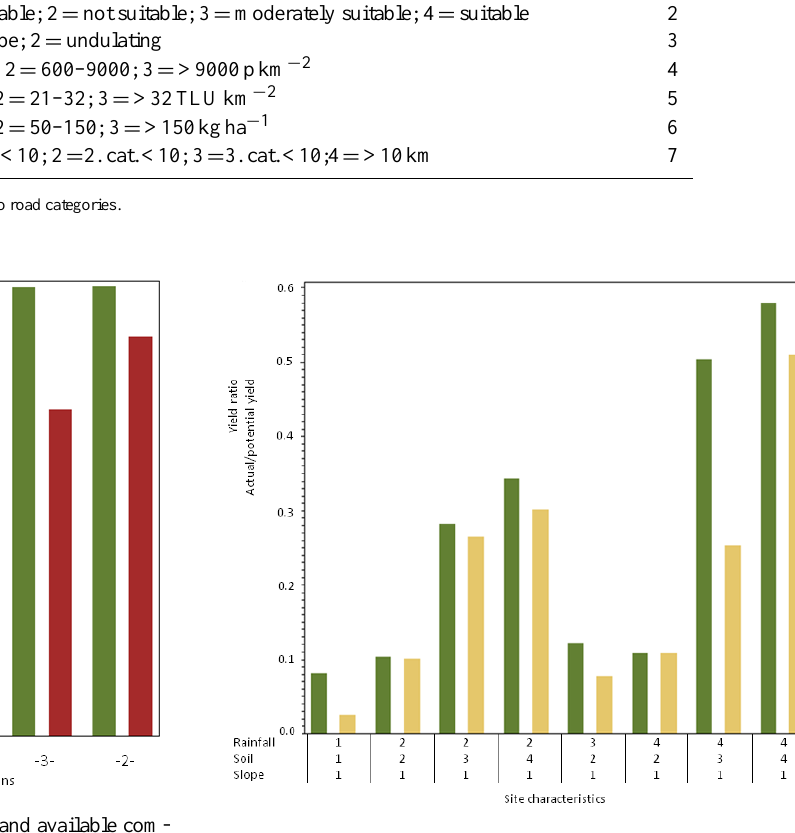
Figure 5. Comparing yields under “low” (green) and “severe” (light brown) degradation for uniform sites defined by three variables (rainfall, soil, and slope). Codes on x axis for rainfall are 1 = <200; 2 = 200–400; 3 = 400–700; 4 = >700mm; for soils 1 = unsuitable; 2 = not suitable; 3 = moderately suitable; 4 = suitable; for slope 1 = no slope ; 2 =